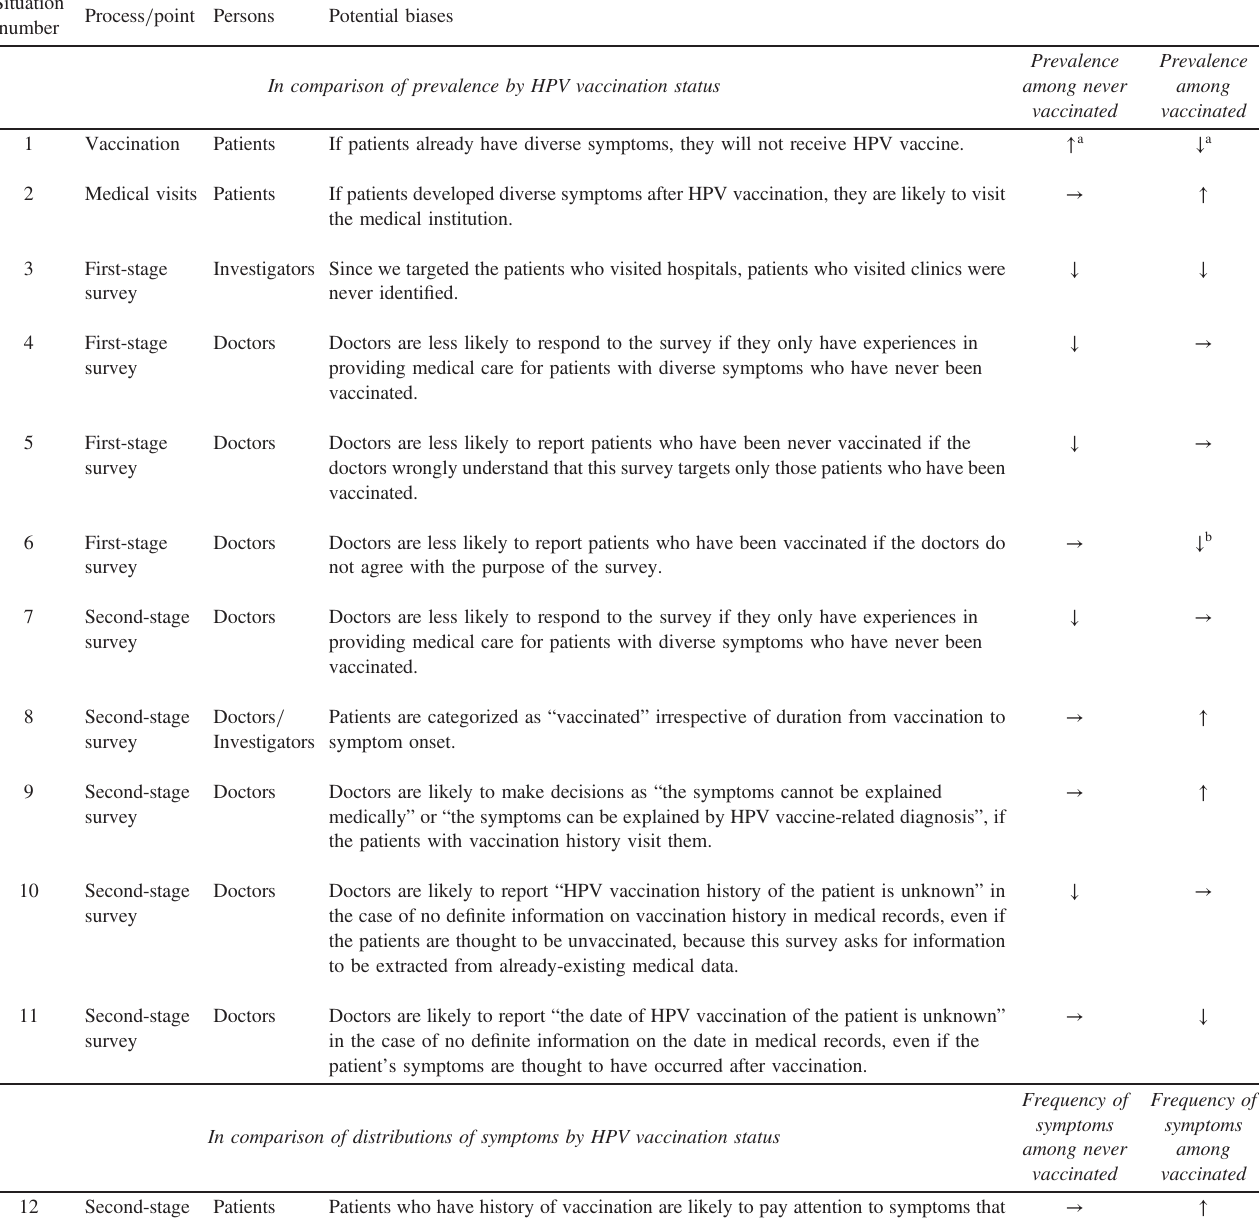
Table 6. Potential biases in comparing prevalence or distributions of symptoms by HPV vaccination status Situation